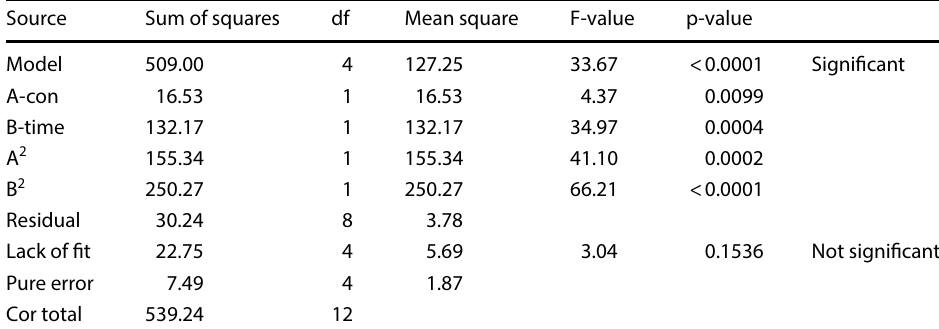
Table 2 ANOVA analysis of acetylation condition